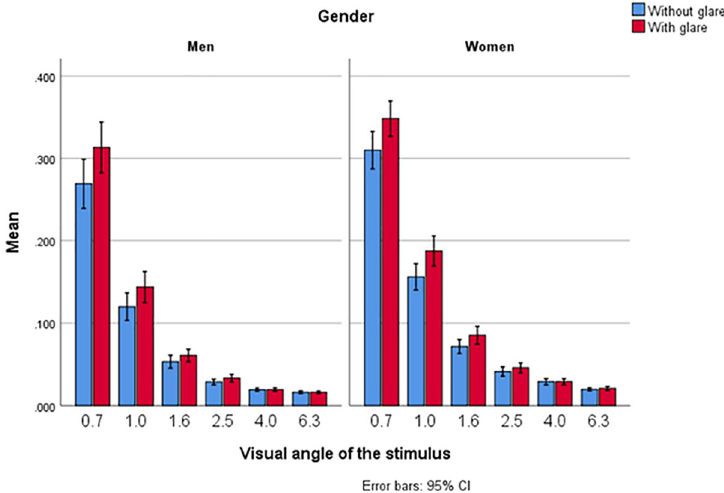
Fig 2. Contrast threshold at different degrees of visual angle, without and with glare (n = 290 eyes, 190 women and 100 men).